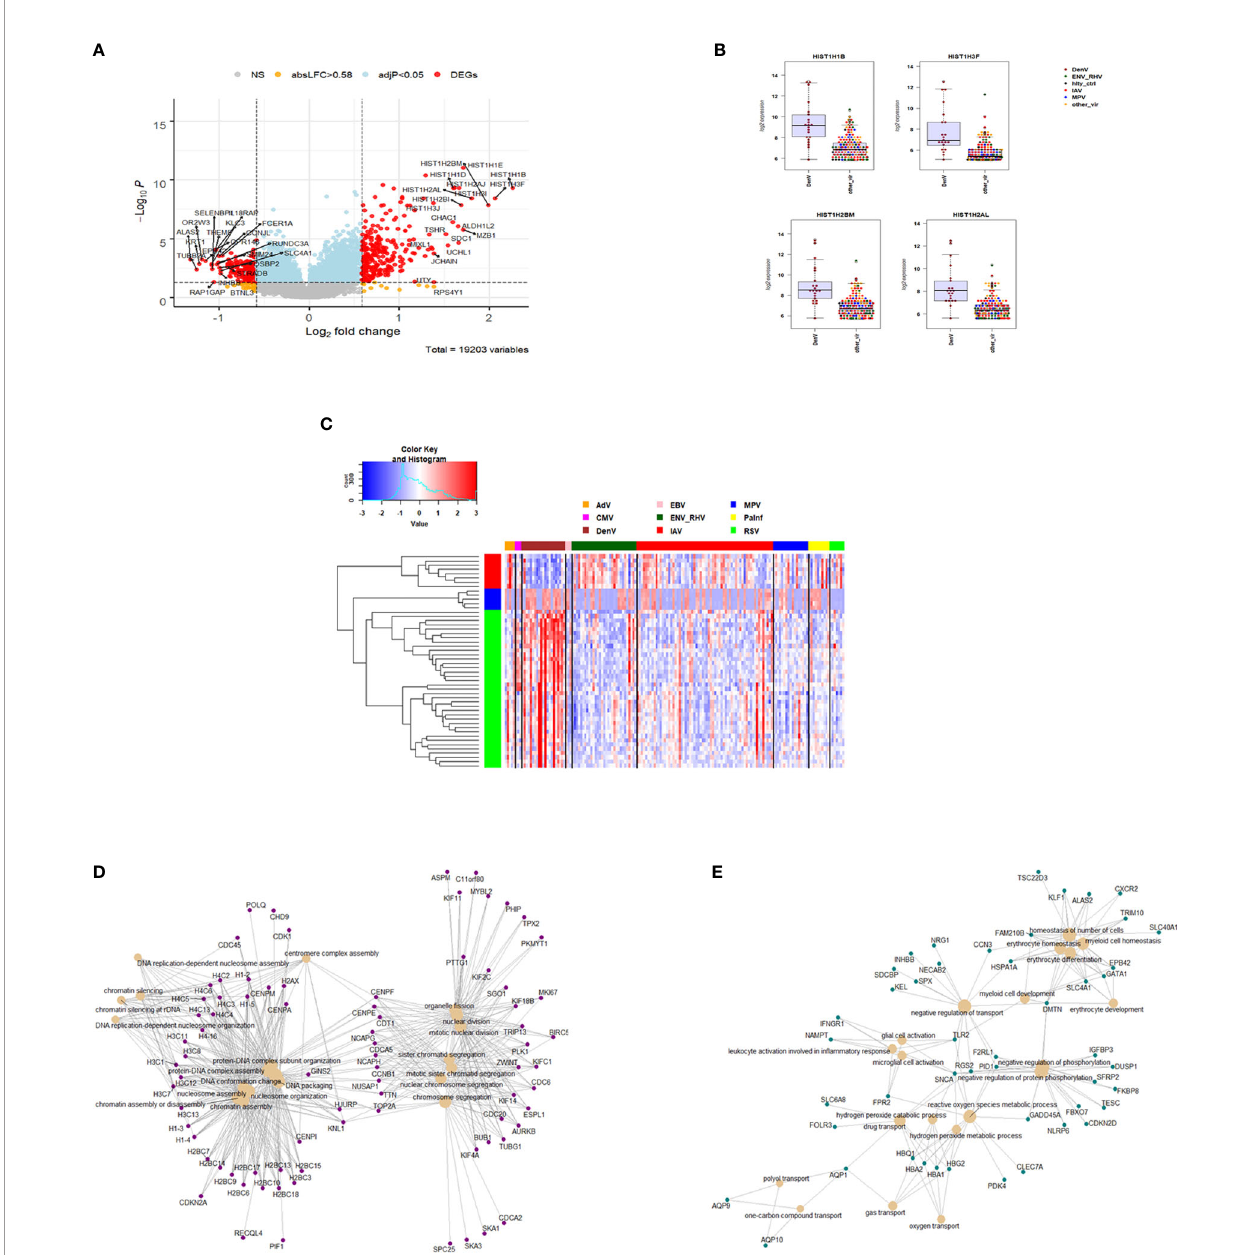
FIGURE 7 | Responses in DENV versus other respiratory infections. (A) Volcano plot of results of the contrast from the linear regression analysis of DENV infected versus all other respiratory virus infections. y-axis: -log 10 BH multiple testing adjusted p-values, x-axis: log 2 fold change. DEGs (absolute log-fold change > 1.5, corresponding to a log 2 -fold change > 0.85; multiple testing adjusted p-value < 0.05) are colored red and the top 20 up- and down-regulated (by log-fold change) DEGs are labeled. Blue: genes with adjusted p-value < 0.05. (B) Gene expression levels of the top four most strongly up-regulated (by absolute fold-change) dengue virus speci fi c DEGs versus all respiratory viruses. HISTH1B : H1.4 Linker Histone, Cluster Member, HIST1H3F : H3 Clustered Histone 7, HIST1H2BM : H2B Clustered Histone 14, HIST1H2AL : H2A Clustered Histone 16. IAV: in fl uenza, ENV_RHV: enterovirus/rhinovirus, MPV: human metapneumovirus, DenV: dengue virus, other_vir: all other respiratory viruses, hlty_contr: healthy controls. (C) Heatmap of normalized expression levels of the top 50 most strongly regulated (by absolute fold-change) DEGs from the contrast of DENV infected patients versus all respiratory infections are presented. Values were scaled by row. red: up-regulated DEGs, blue: down- regulated DEGS. IAV, in fl uenza virus; ENV_RHV, enterovirus/rhinovirus; MPV, metapneumovirus; PaInf, parain fl uenza virus; RSV, respiratory syncytial virus; AdV, adenovirus; CMV, cytomegalovirus; EBV , Epstein-Barr virus; DENV, dengue virus. (D) Functional analysis using GO term enrichment for the DEGs from the contrast of DenV infected versus all other respiratory virus infections. Network of top 20 up-regulated pathways and associated genes. Red: up-regulated. (E) Functional analysis using GO term enrichment for the DEGs from the contrast of DENV infected versus all other respiratory virus infections. Network of top 20 down-regulated pathways and associated genes. Green: down-regulated. NS, not signi fi